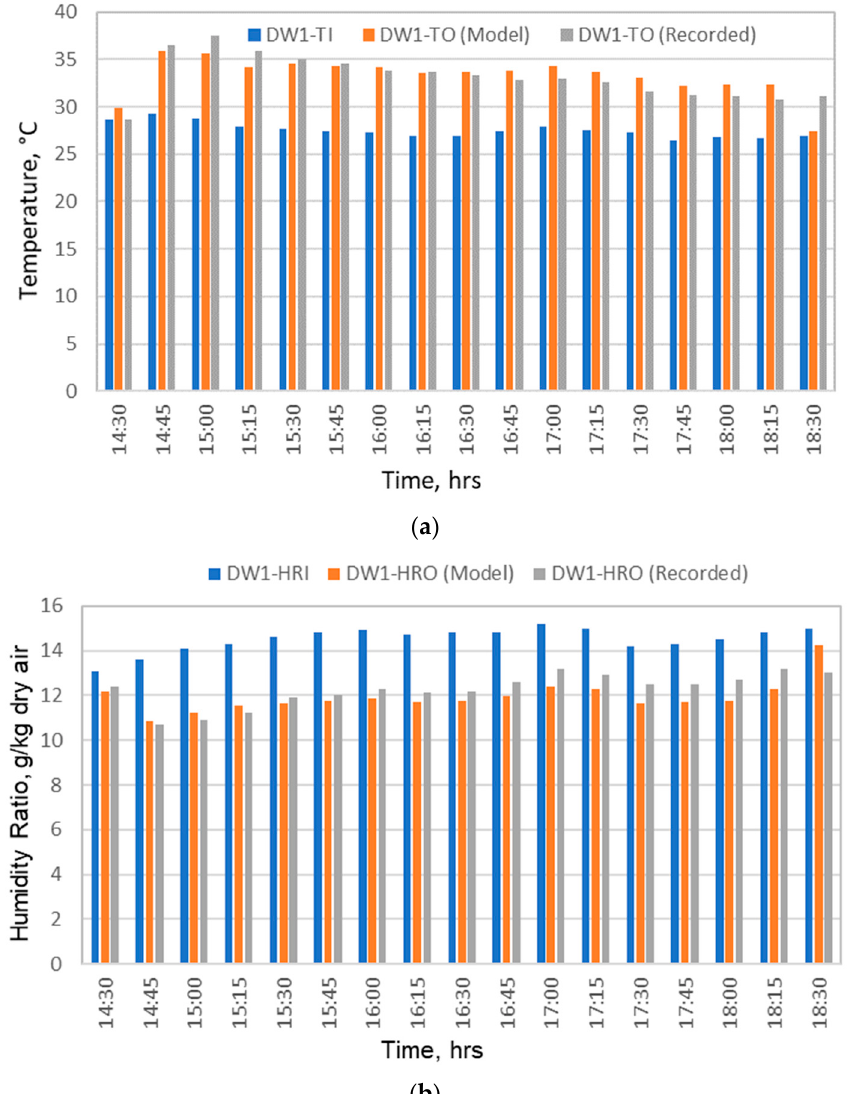
Figure 5. ( a ) Modelled and recorded values of temperature across DW1 for day II, and ( b ) modelled and recorded values of humidity ratio across DW1 for day II.